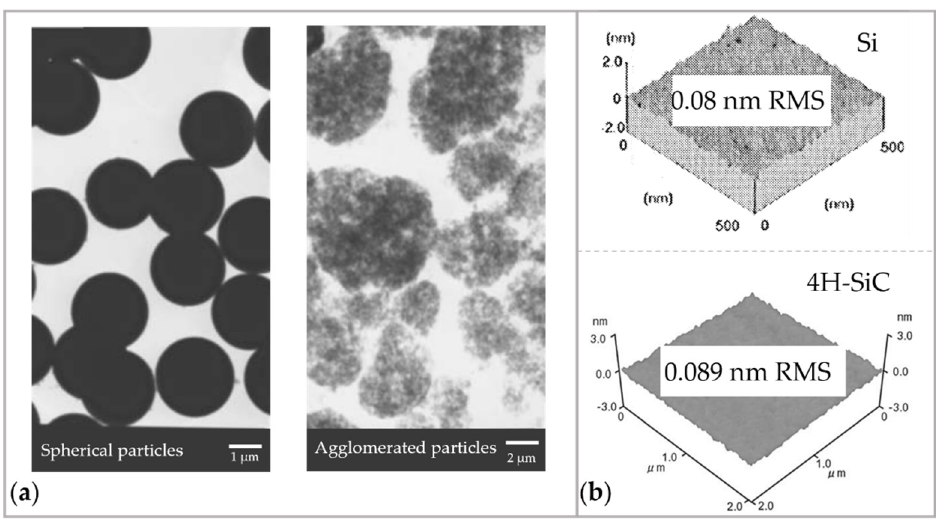
Figure 24. Application of elastic emission machining: ( a ) The TEM images of silica powder particles. Reproduced with permission from [175]; ( b ) The AFM images of different materials processed by elastic emission machining. Reproduced with permission from [172,176].